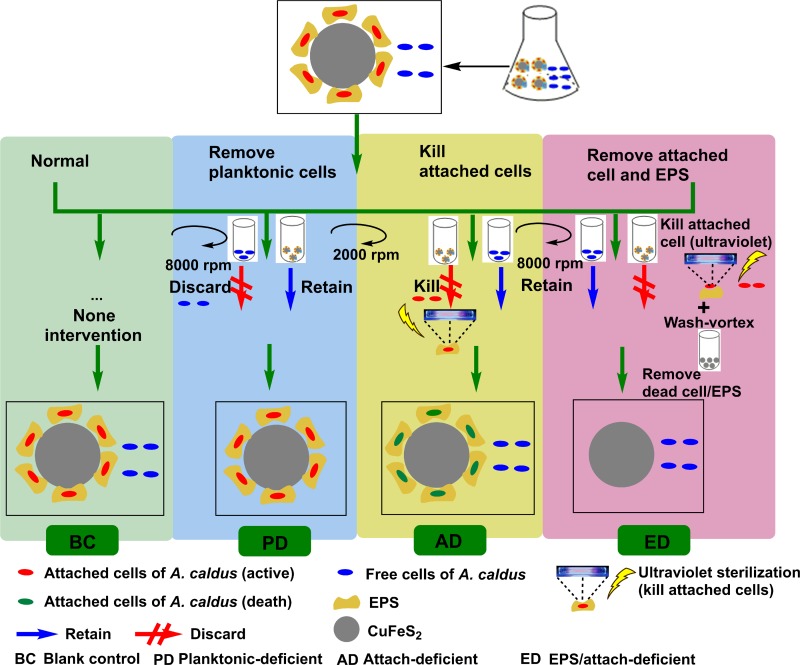
The experimental setup of the different bioleaching procedures designed for this study:
A. caldus blank control system (BC); A. caldus planktonic cells-deficient system (PD); A. caldus attached cells-deficient system (AD); A. caldus EPS /attached cells-deficient system (ED).